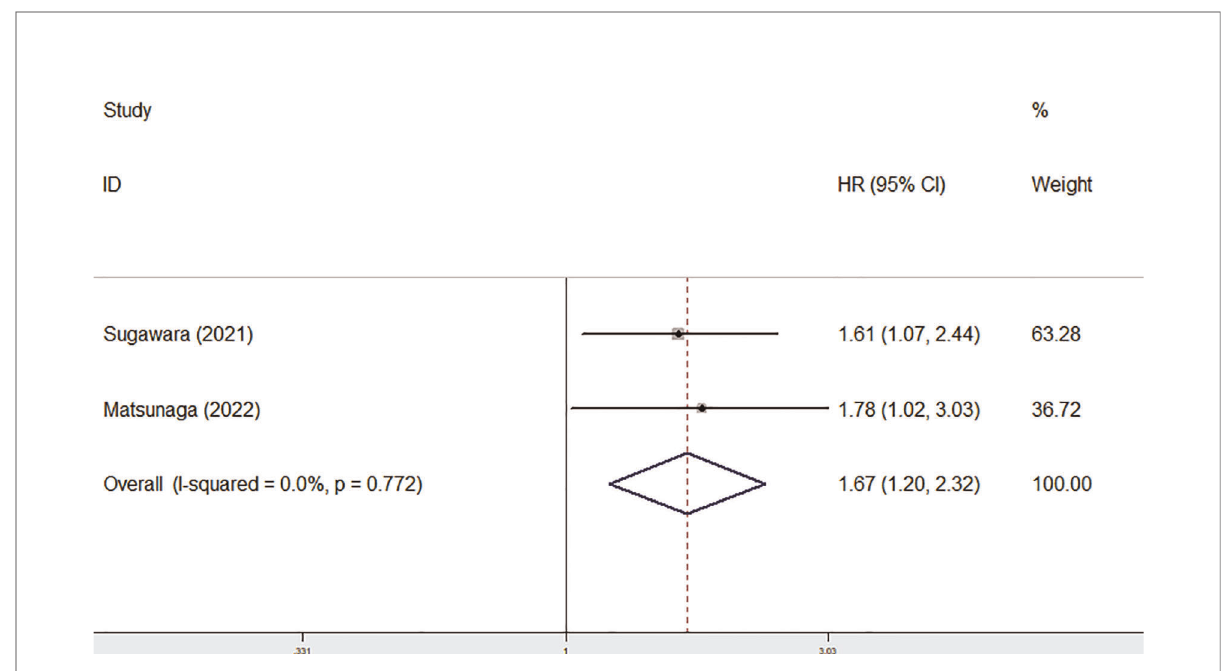
FIGURE 3 The association between preoperative geriatric nutritional risk index and cancer-speci fi c survival of surgical gastric cancer patients.